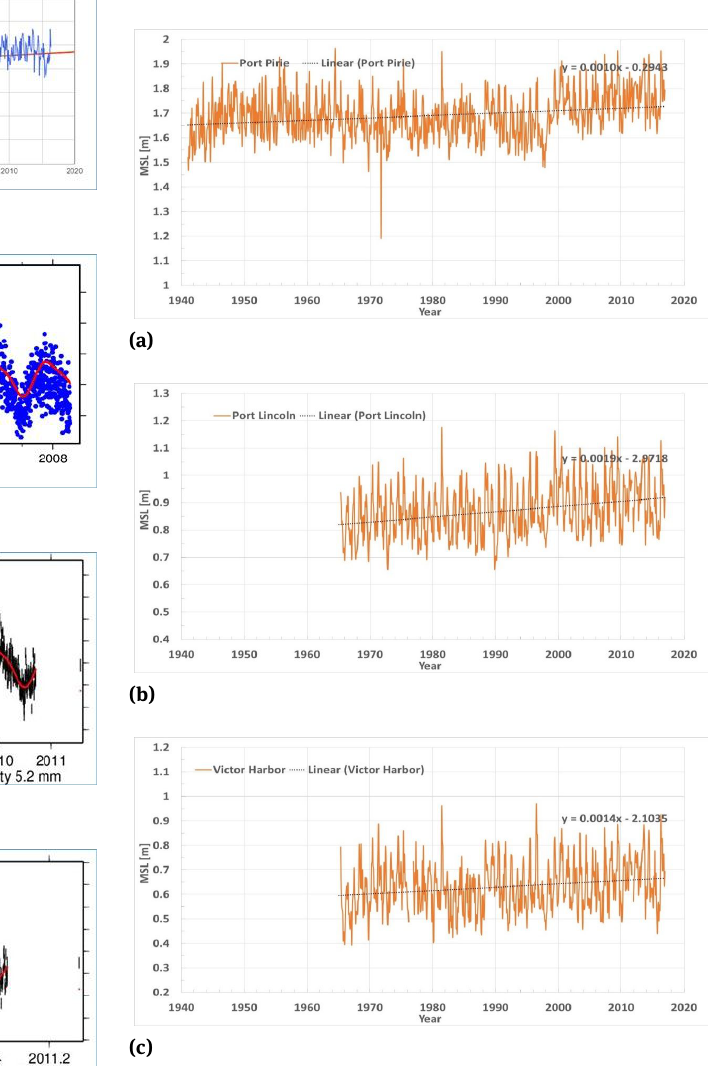
Figure 19: Relative sea-level rise around Adelaide. MSL data from